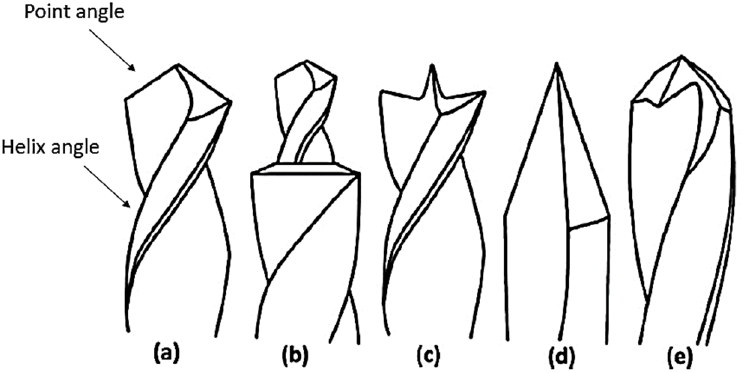
Figure 12. Different tool geometries used in drilling: ( a ) standard twist drill, ( b ) step drill, ( c ) Brad point drill bit, ( d ) straight flute drill bit (dagger) and ( e ) multifaceted drill bit (adapted from [54]).